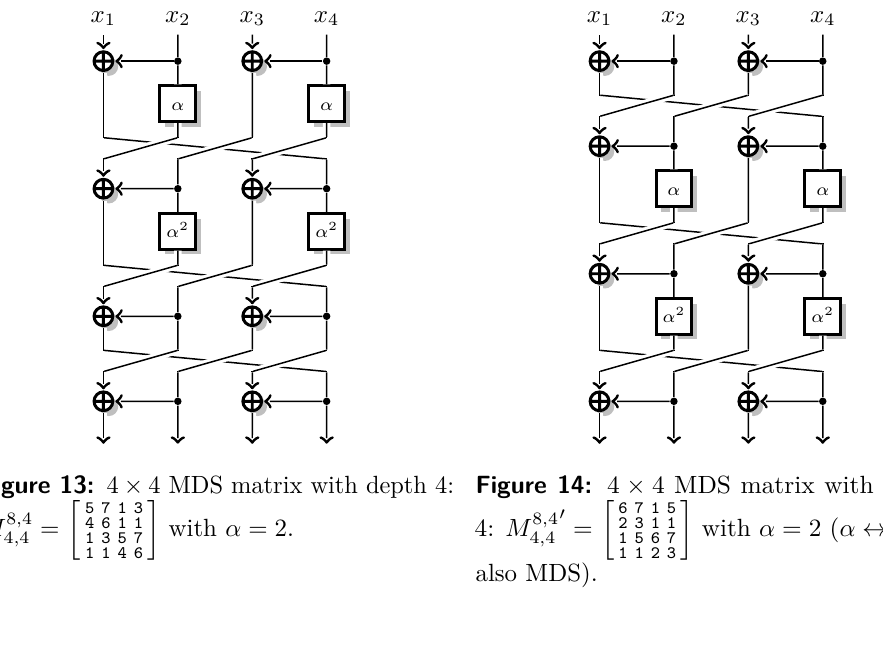
Figure 14: 4 × 4 MDS matrix with depth